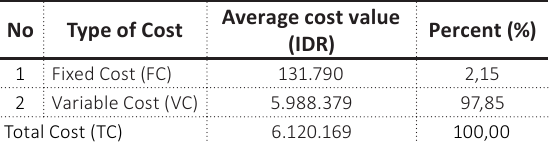
Table 3. Total average costs of corn producers per ha/planting season